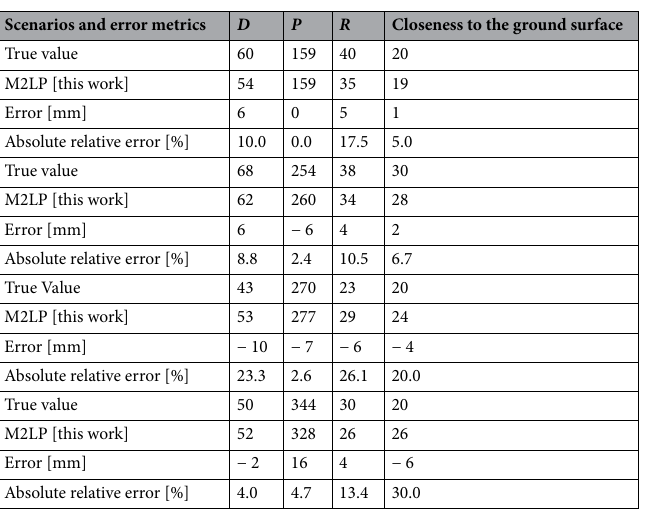
Table 8. Characteristic parameter prediction of the proposed M2LP framework assuming short distance between the object and the ground surface. Explanation of terms: D —depth, P —lateral position, R —radius and closeness to the ground surface (all in mm).